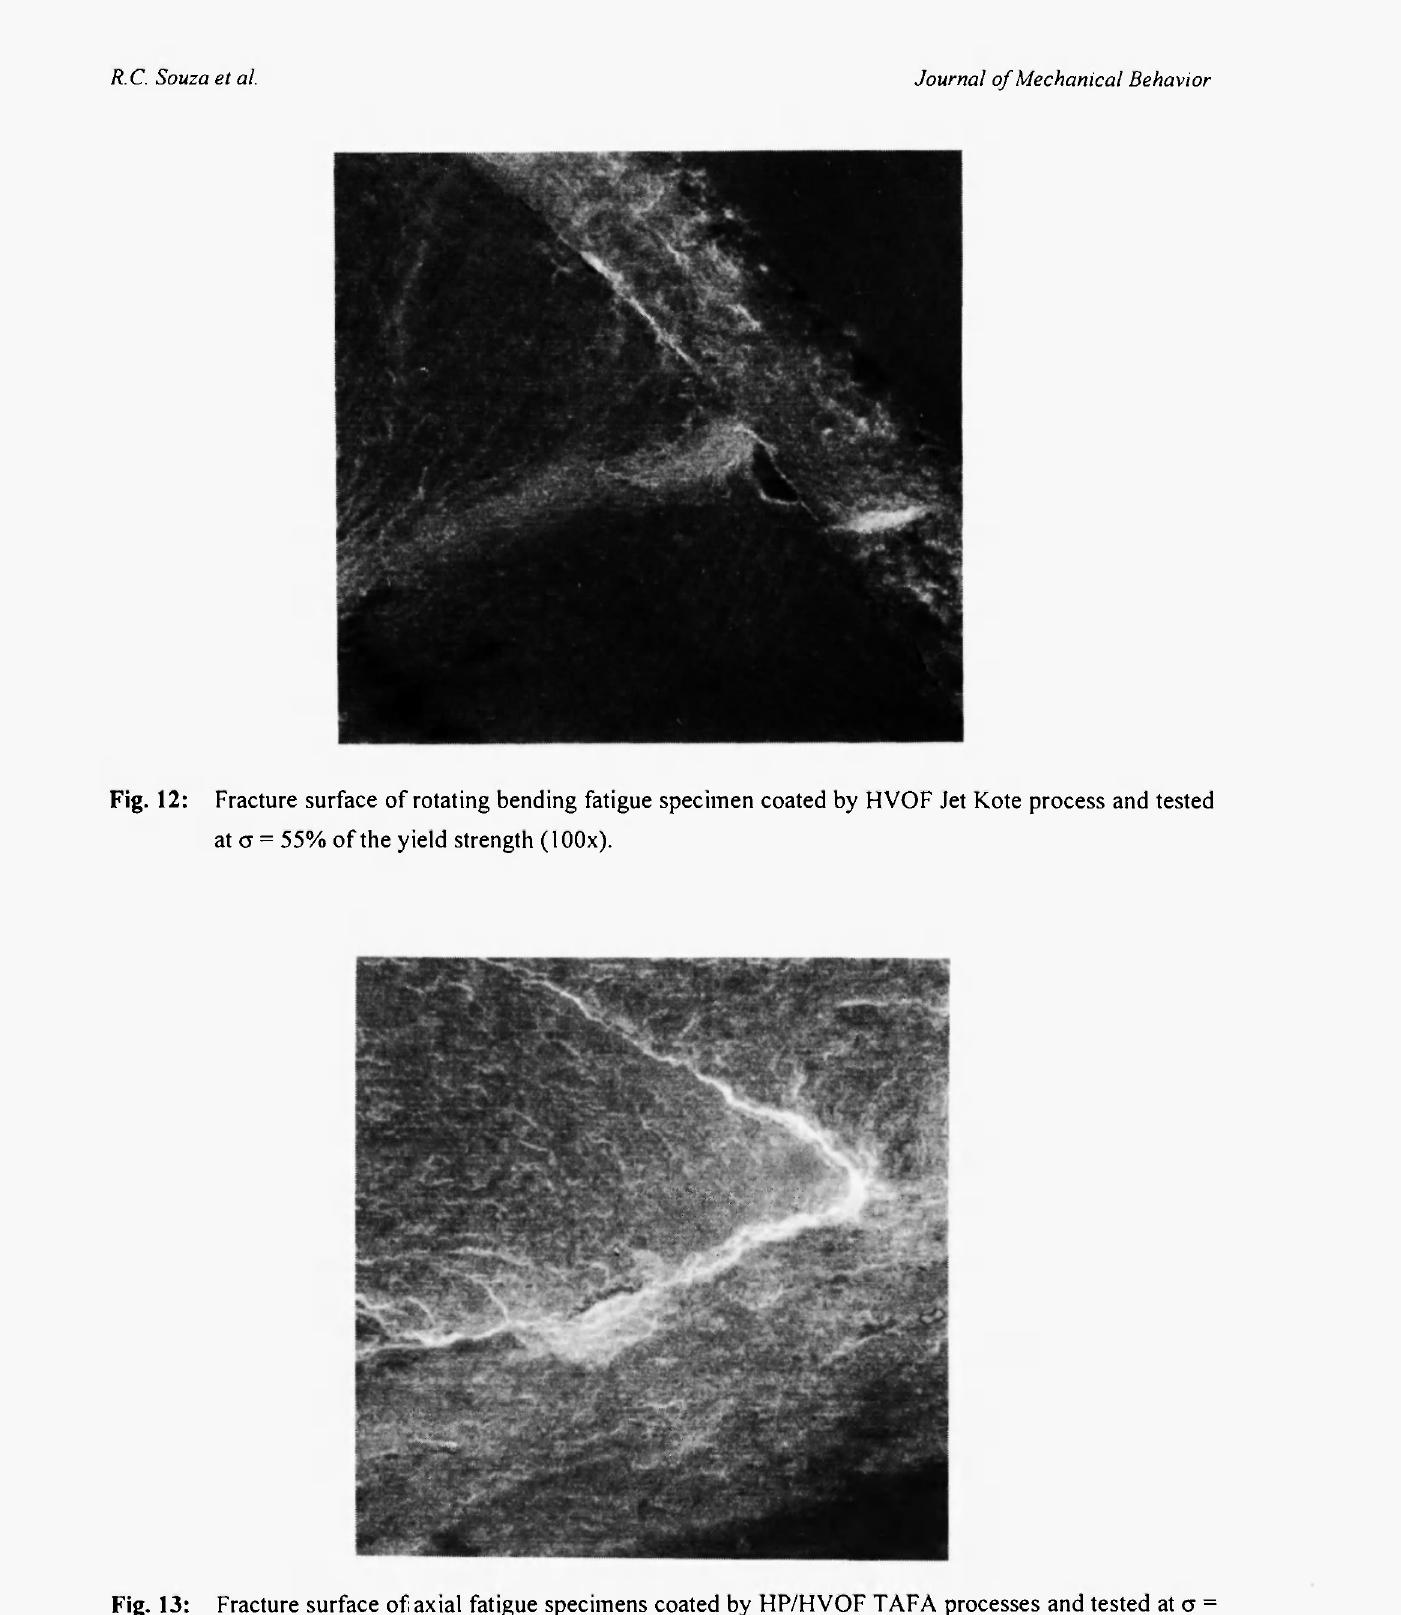
Fig. 13: Fracture surface of axial fatigue specimens coated by HP/HVOF TAFA processes and tested at σ = 67.8 % of the yield strength (21